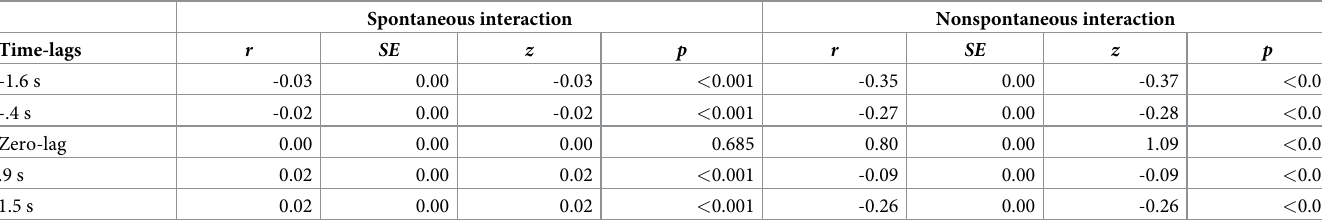
Table 1. Peaks of cross-correlation values for spontaneous and nonspontaneous